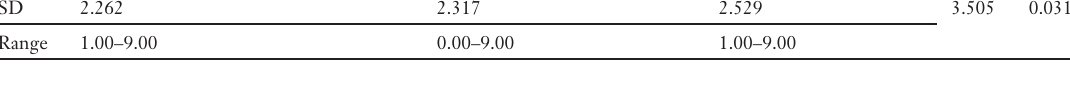
VAS scores in school- age children of the three groups.